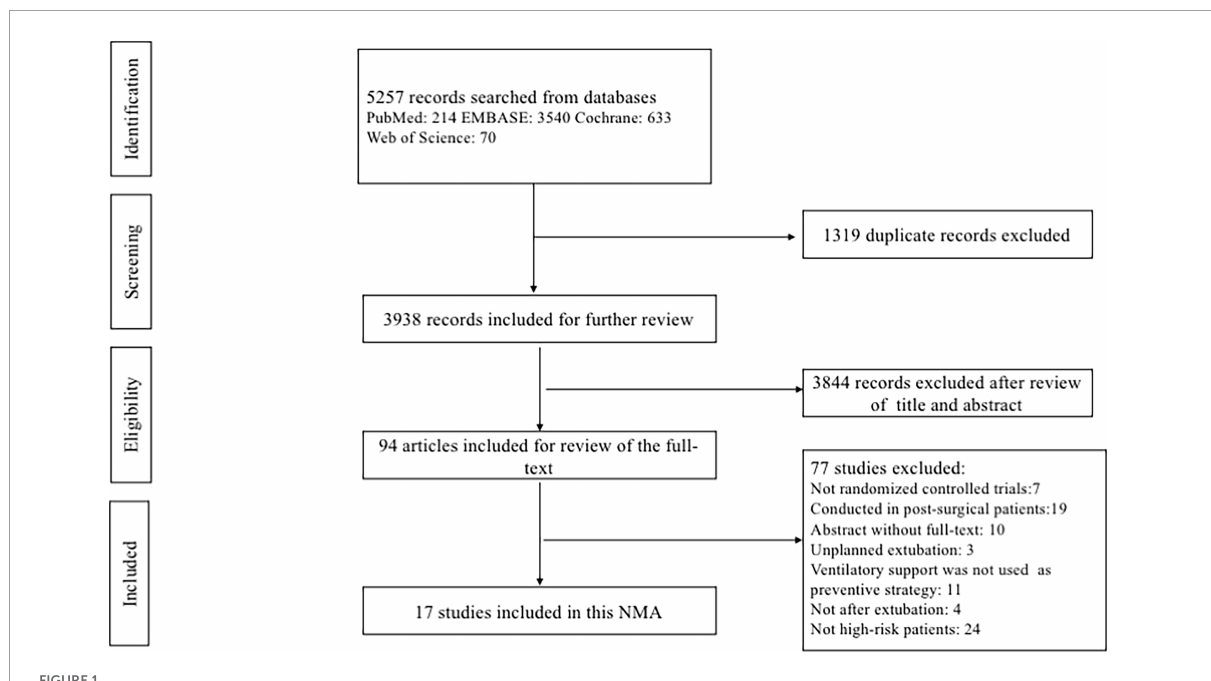
FIGURE1 PRISMA flowchart for the study selection process. NMA, network